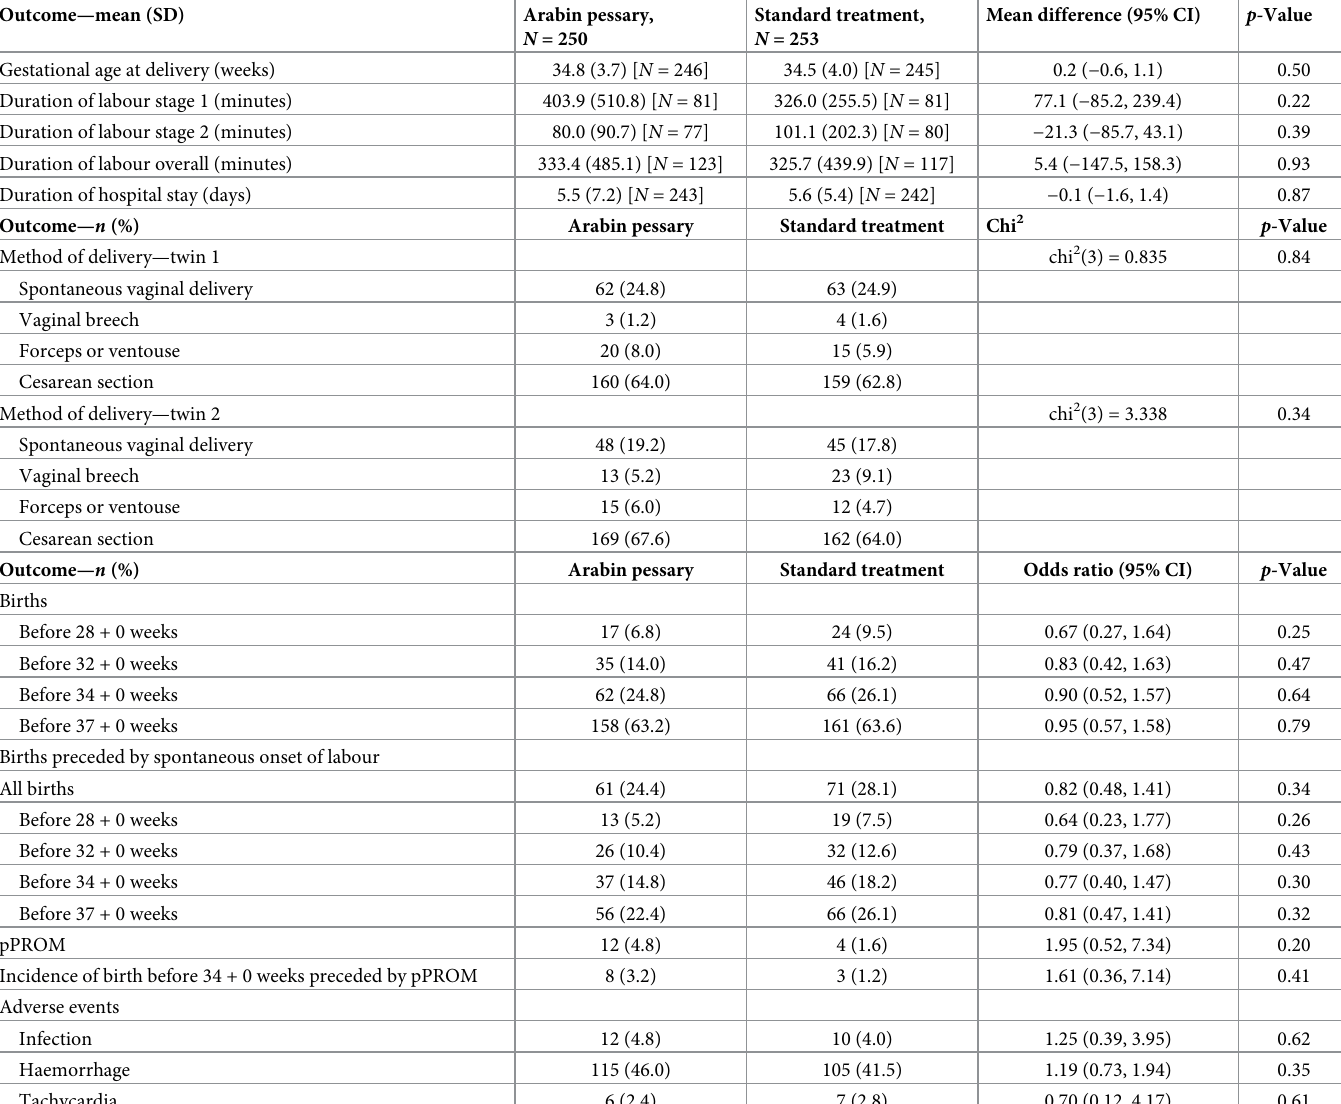
Table 4. Secondary obstetric